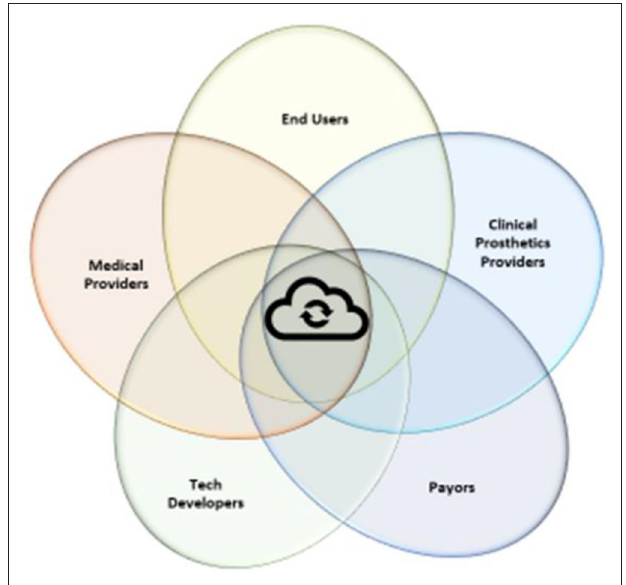
FIGURE 2 | Innovation will take place as various experts and bodies of knowledge co-create synergistically through the sharing of expertise and knowledge where they overlap with the other fields. The hub of this sharing will be data